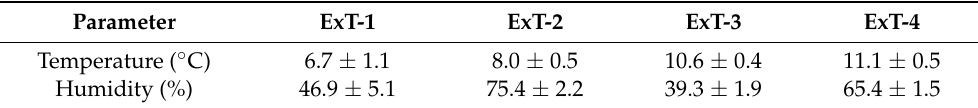
Table 2. Mean air temperature and humidity during exercise tests 1 to 4 (ExT-1 to ExT-4). Parameter Temperature ( ◦